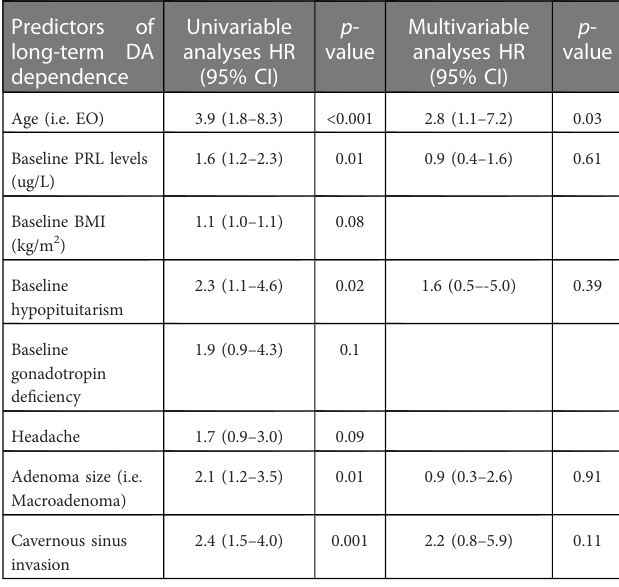
TABLE 3 Predictors of long- term dependence on dopamine